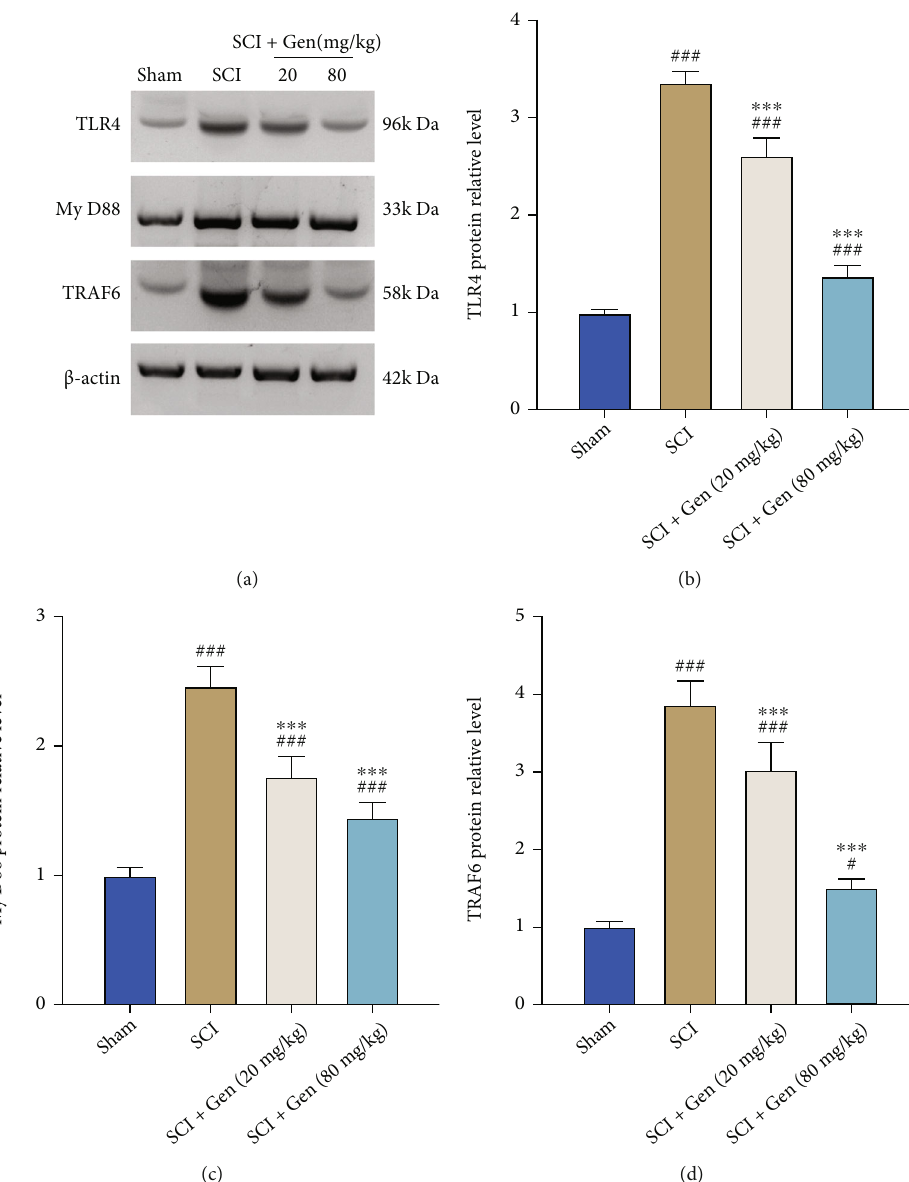
Figure 5: Genistein inhibited TLR4-mediated MyD88-dependent signaling pathway in SCI mice. (a – d) 28 days after genistein treatment, we used immunoblotting to detect the expression of TLR4, MyD88, and TRAF6 protein in the SCI area, and the representative protein bands were showed in (a), and the gray value comparison of protein bands was shown in (b) – (d). Five mice in each group, and data were expressed as mean ± SD . P value was calculated by post hoc comparisons. ∗∗∗ P < 0 : 001 vs. SCI group. # P < 0 : 05 and ### P < 0 : 001 vs. sham